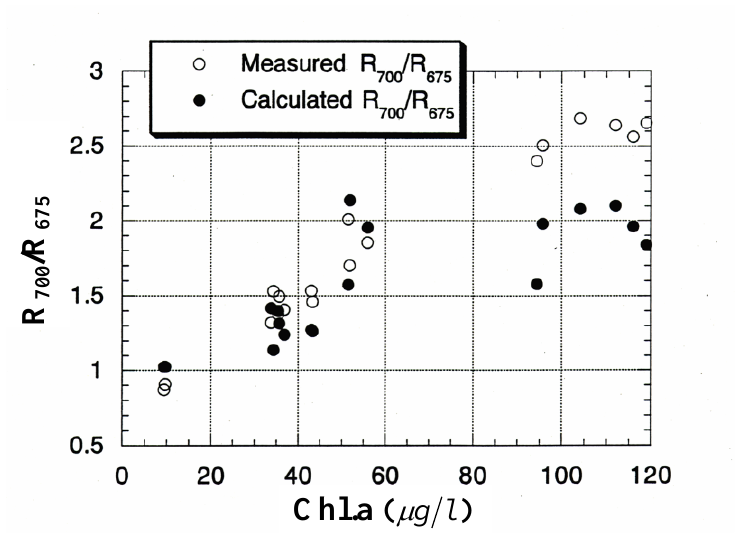
/R value 700 675